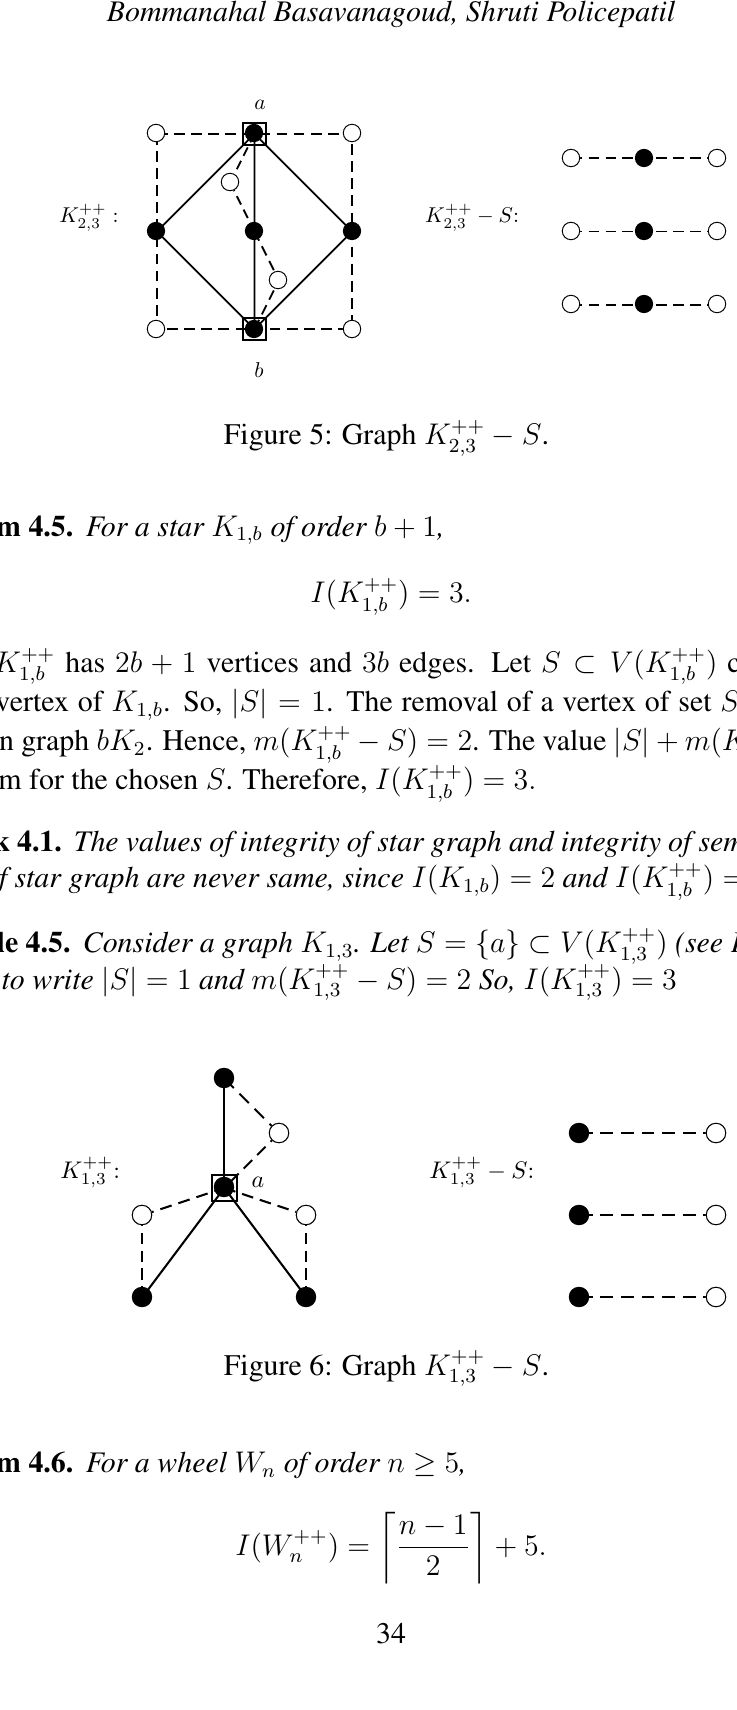
Figure 5: Graph K ++